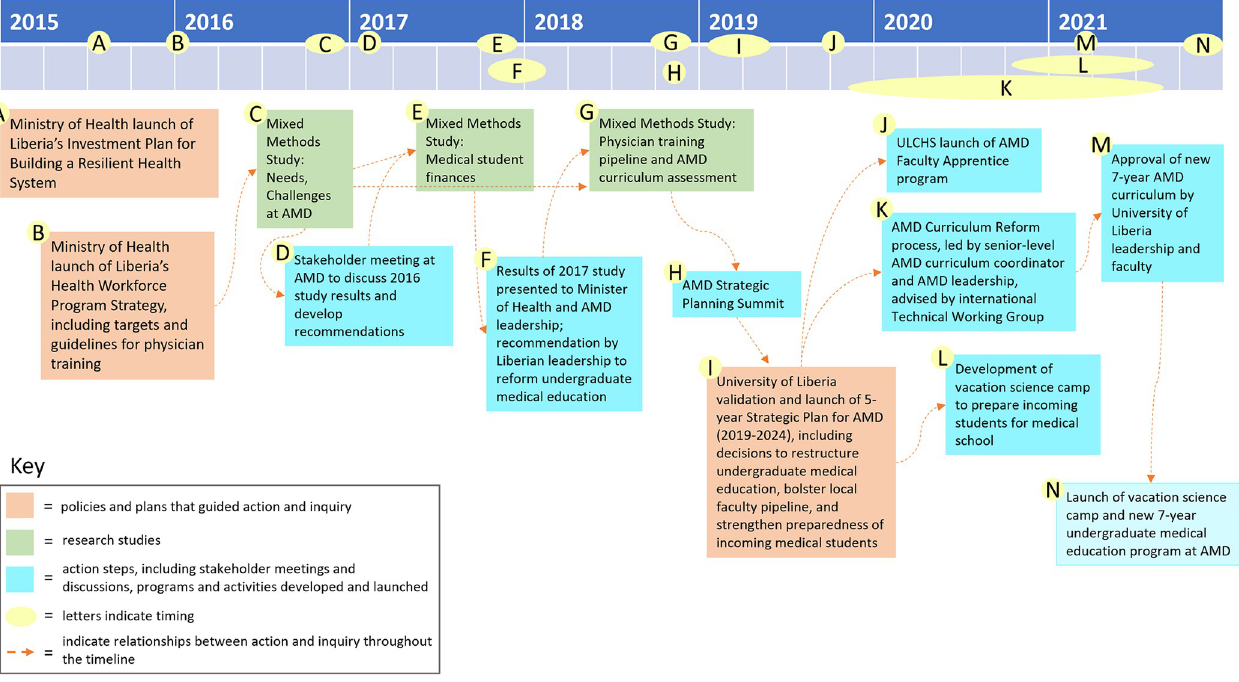
�� Negative correlation values indicate inverse effect (e.g. students who answered “disagree or strongly disagree” that faculty were generally helpful were significantly more likely to have considered dropping out or wonder about graduating).